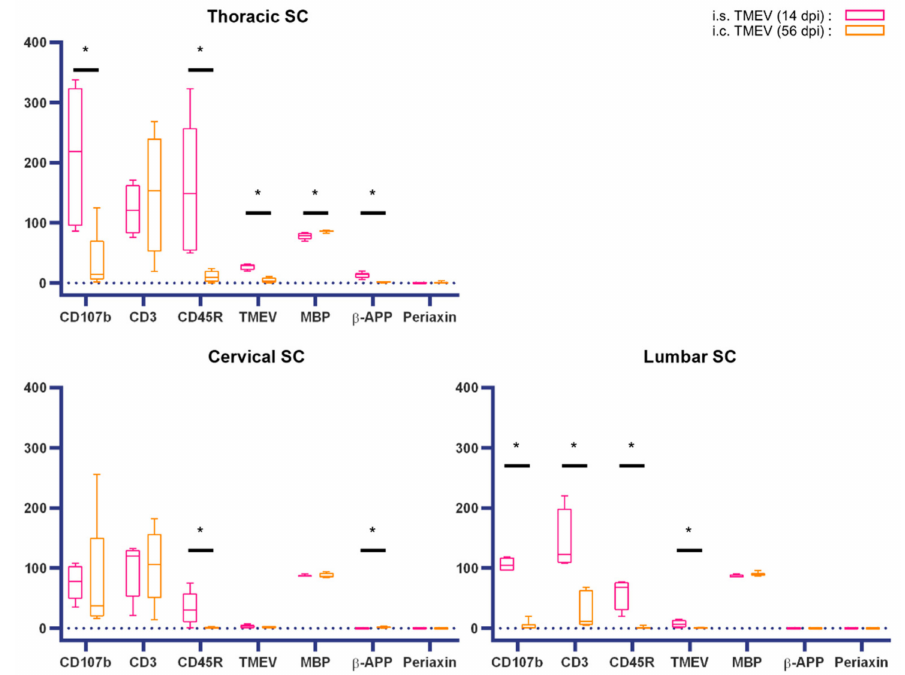
Figure 10. Comparison of a spinal cord (SC) lesion in intraspinal (i.s.) versus intracerebral (i.c.) TMEV-infected mice at 14 or 56 days post infection (dpi), respectively. Data are given for each spinal cord (SC) segment separately including numbers of immunolabeled cells for CD107b (microglia / macrophages), CD3 (T lymphocytes), CD45R (B lymphocytes), TMEV (Theiler’s